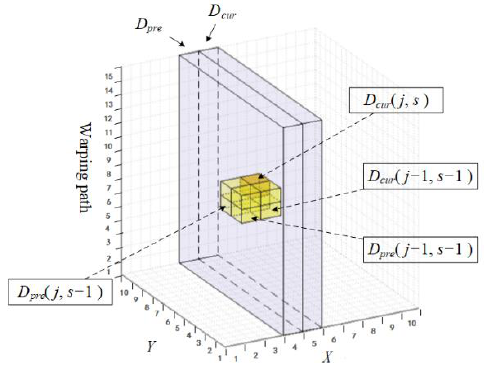
Figure 3. The proposed two-channel alternating matrix within the CDM space.